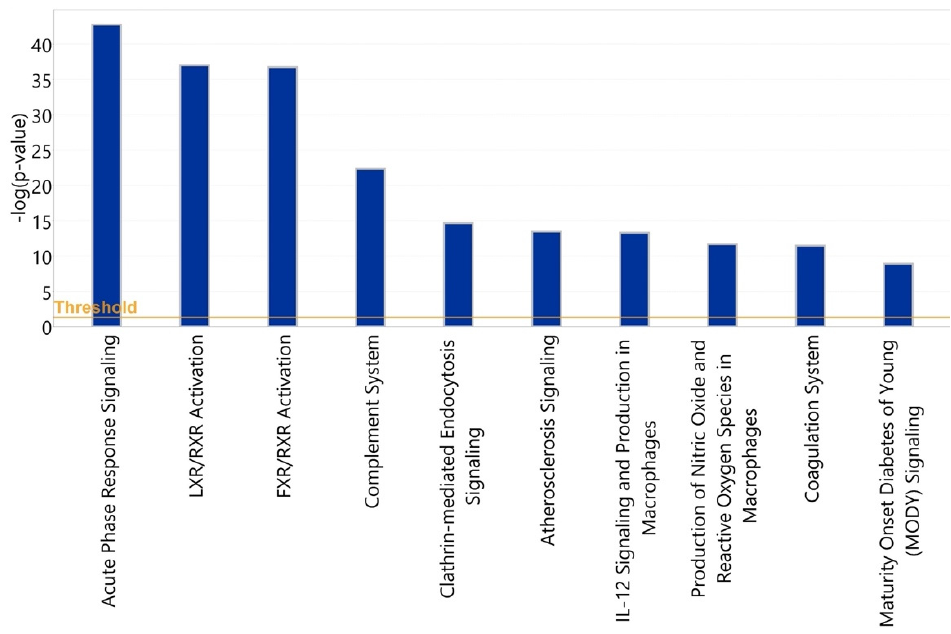
Figure 15. Statistical significance levels of differential activation of canonical pathways among asymptomatic vs. symptomatic COVID-19 patients.